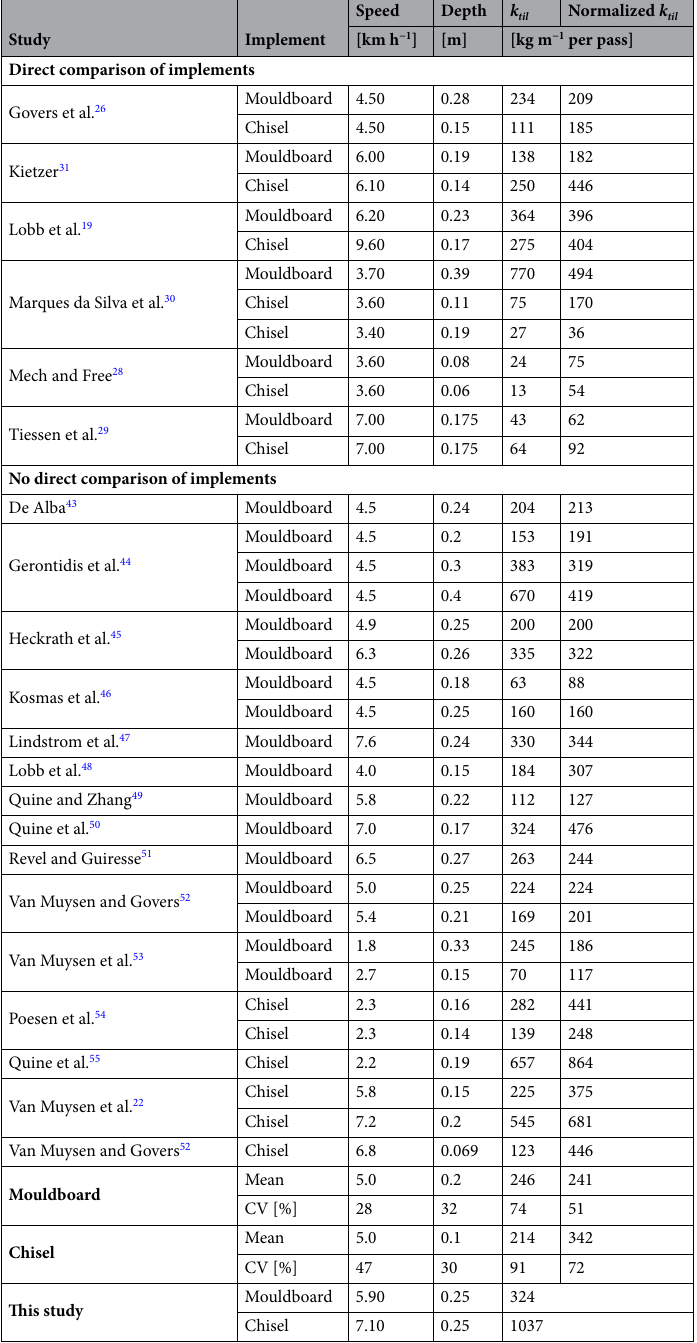
Table 2. Comparison of tillage erosion coefficients ( k til ) for inversion (mouldboard plough) vs. non-inversion (chisel plough) up- and down-slope tillage. The normalized k til is calculated for a tillage depth of 0.25